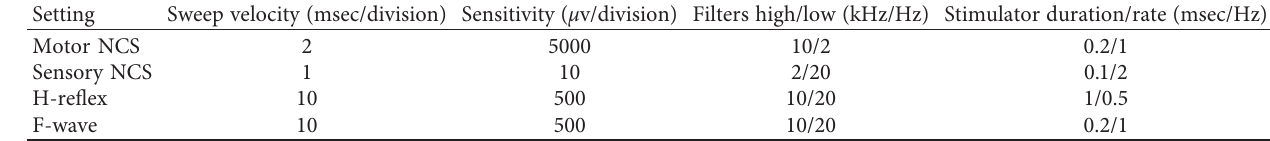
Table 1: Machine setting for nerve conduction studies [16].